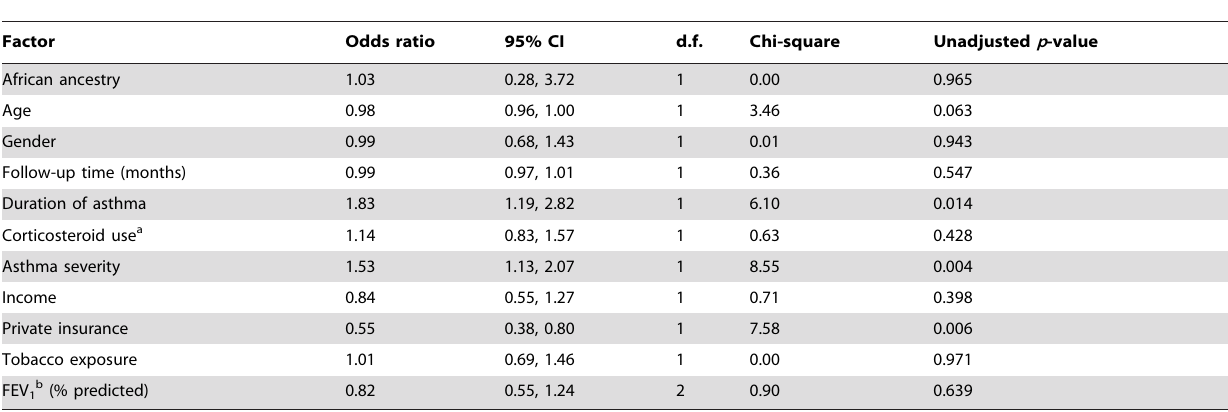
Table 3. Association of demographic, socioeconomic, clinical and genetic factors with asthma exacerbations in CHIRAH study.